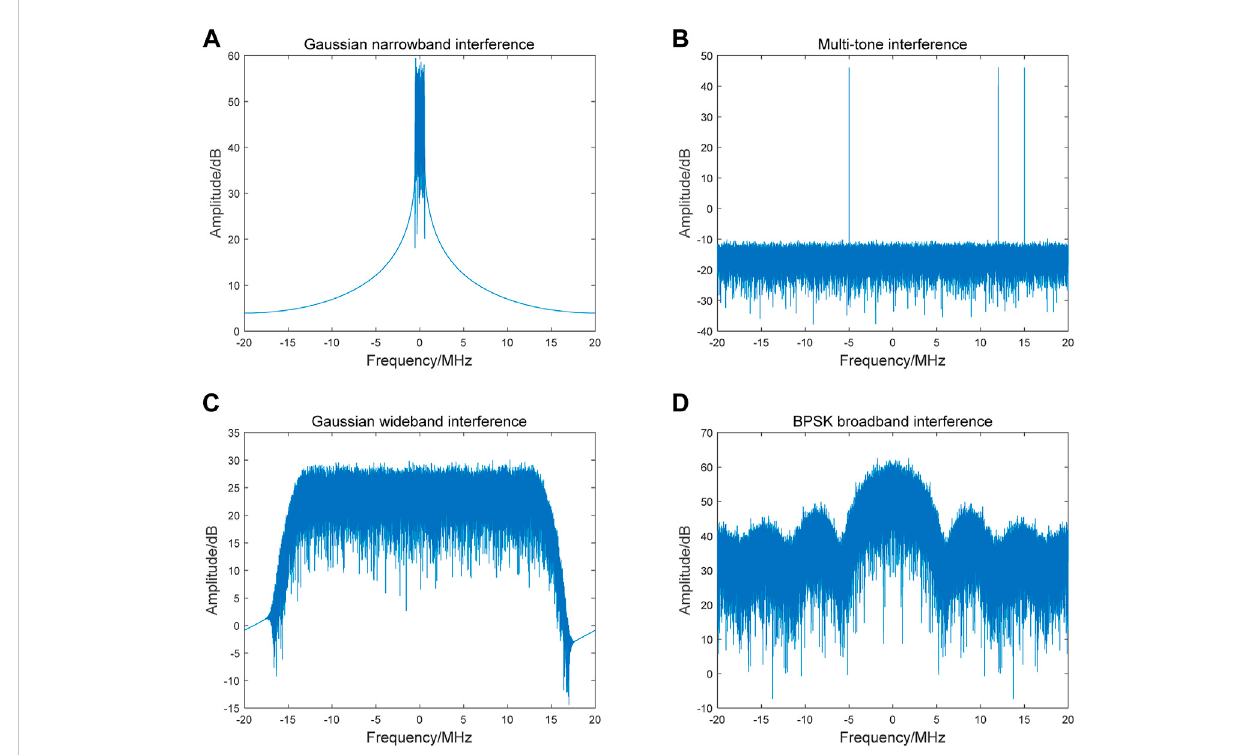
FIGURE 2 The frequency spectra of common blanket interference types: (A) Gaussian narrowband interference; (B) multitone interference; (C) Gaussian broadband interference (D) BPSK broadband interference.